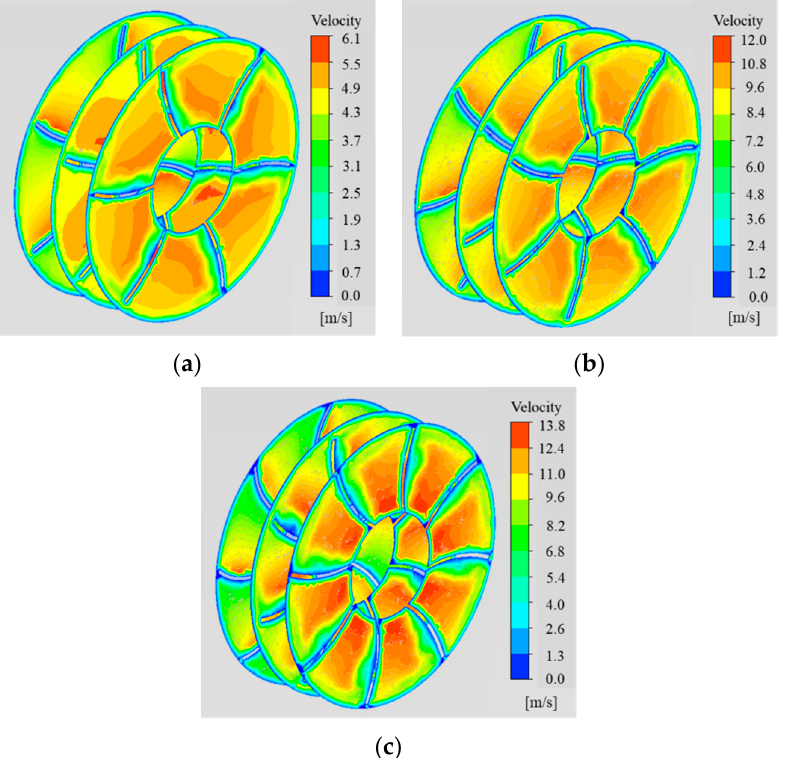
Figure 10. Cloud map of velocity distribution at different positions of the turbine. ( a ) 6 − blade turbine velocity distribution cloud map. ( b ) 7 − blade turbine velocity distribution cloud map. ( c ) 8 − blade turbine velocity distribution cloud map.